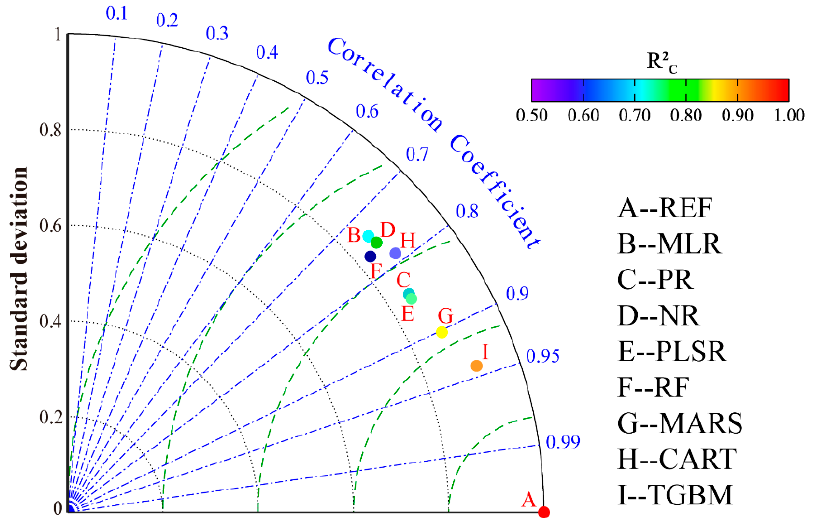
Figure 16. Taylor diagram of model accuracy evaluation of calibration set.